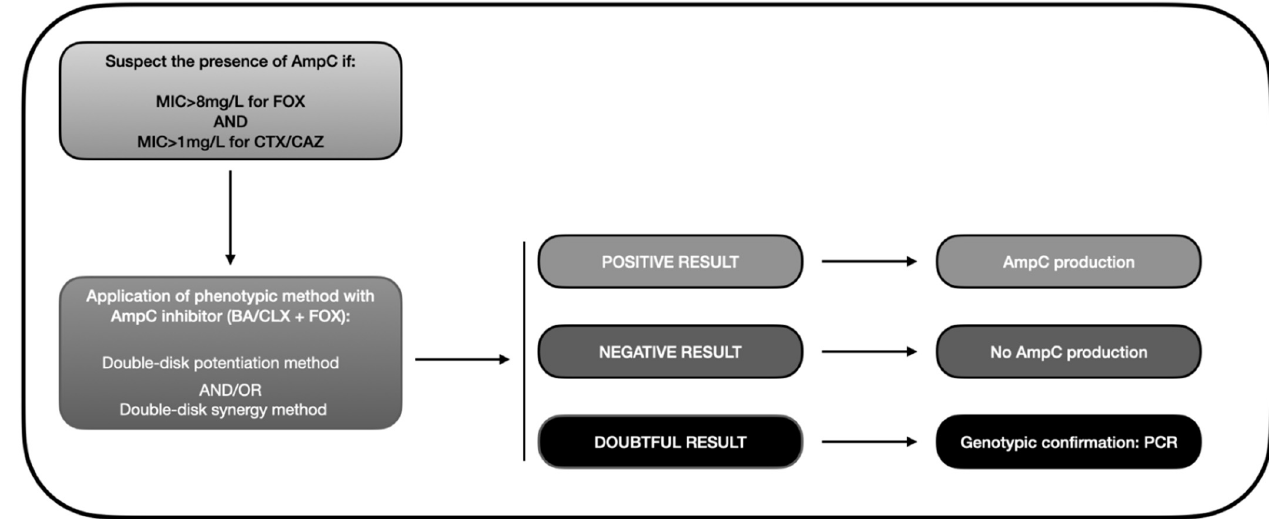
Figure 3. Diagnostic algorithm for the phenotypic detection of AmpC-BL (based on data from the review). MIC: minimum inhibitory concentration; FOX: cefoxitin; CAZ: ceftazidime; BA: boronic acid; CLX: cloxacillin; PCR: polymerase chain reaction.